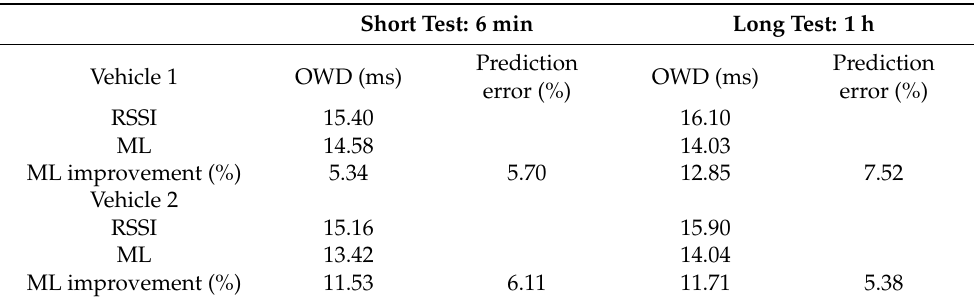
Table 2. A summary of emulation results when ML-based decision making was compared to the reference (heuristic approach).